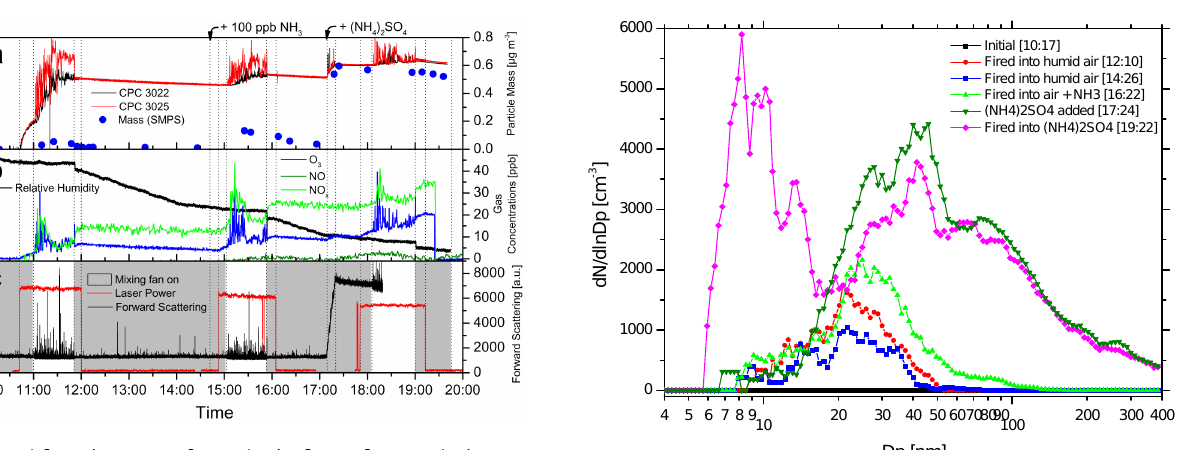
Fig. 4. Particle and trace gas formation by laser filaments in the syn- thetic air for experiments 4, 6, and 7 at 283K and ∼ 60% RH. The different panels show (a) particle number (red and black lines) and mass (blue circles); (b) relative humidity (black line), ozone (blue line, NO (dark green line) and NO x concentrations (light green line); (c) near-forward scattering (black line), laser power (red line) and mixing fan operation (grey shaded area).